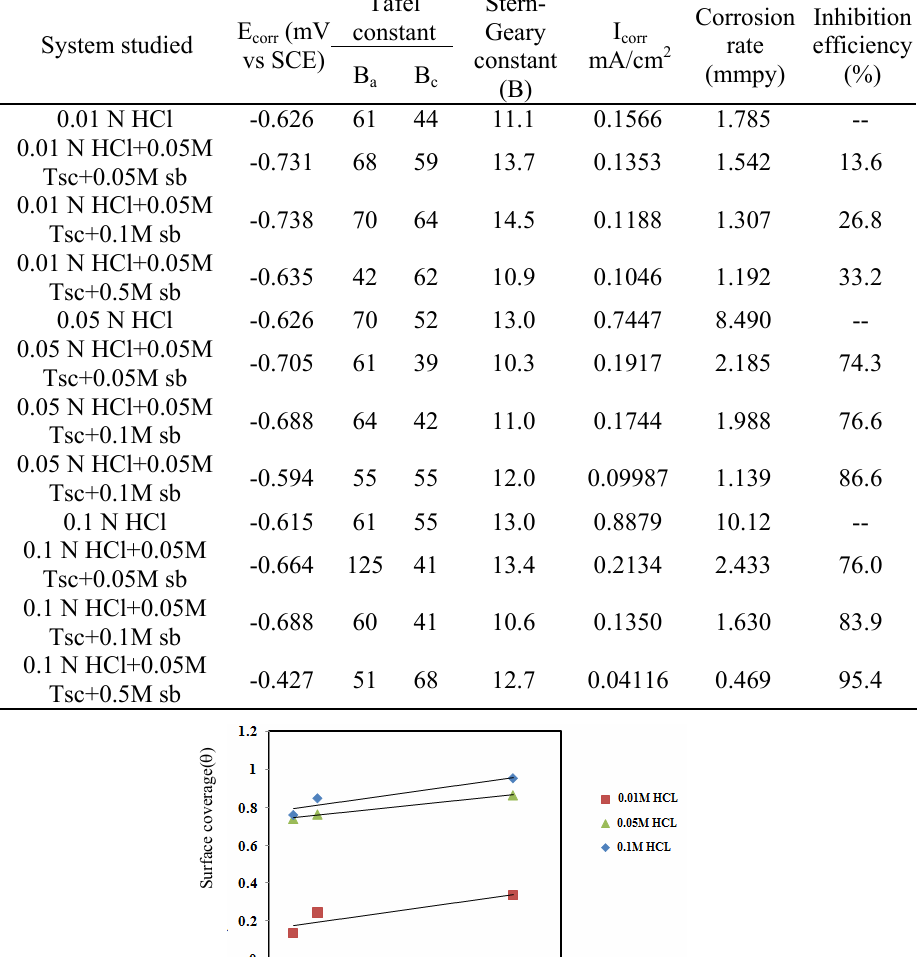
Table 2 . Polarisation parameter for the corrosion of mild steel in different concentration of